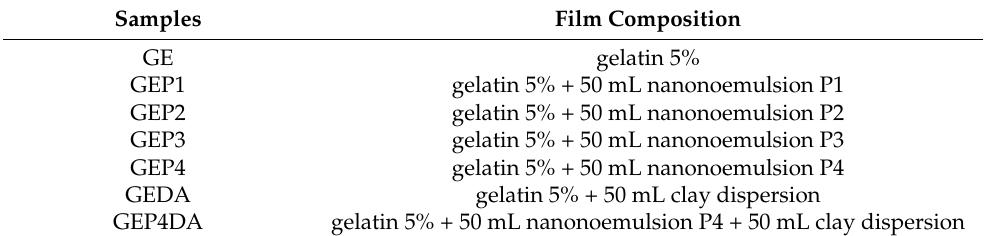
Figure 1. Schematic graphic of the film preparation. Table 1. Film composition.